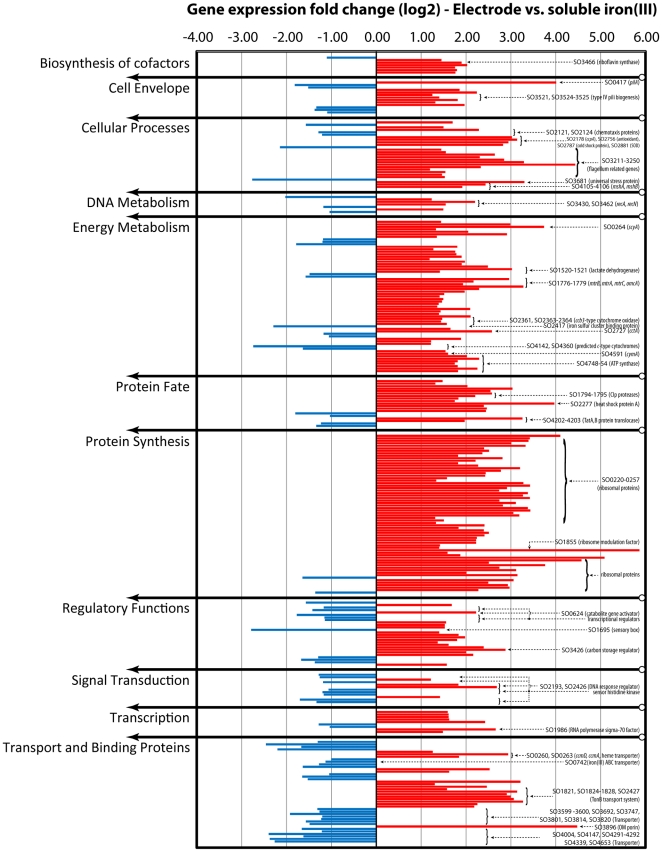
Differential expression levels of selected genes in comparision 1 (El vs. Fe).Bar diagram showing the over and under expression of selected genes with the electrode in Comparison 1 (electrode vs. soluble iron[III]). The selection includes transcripts of interest with q≤0.05 and |logFC|<1, which have been designated by * in Table S1. Genes are clustered into functional groups. Most genes discussed in the text have been labelled.